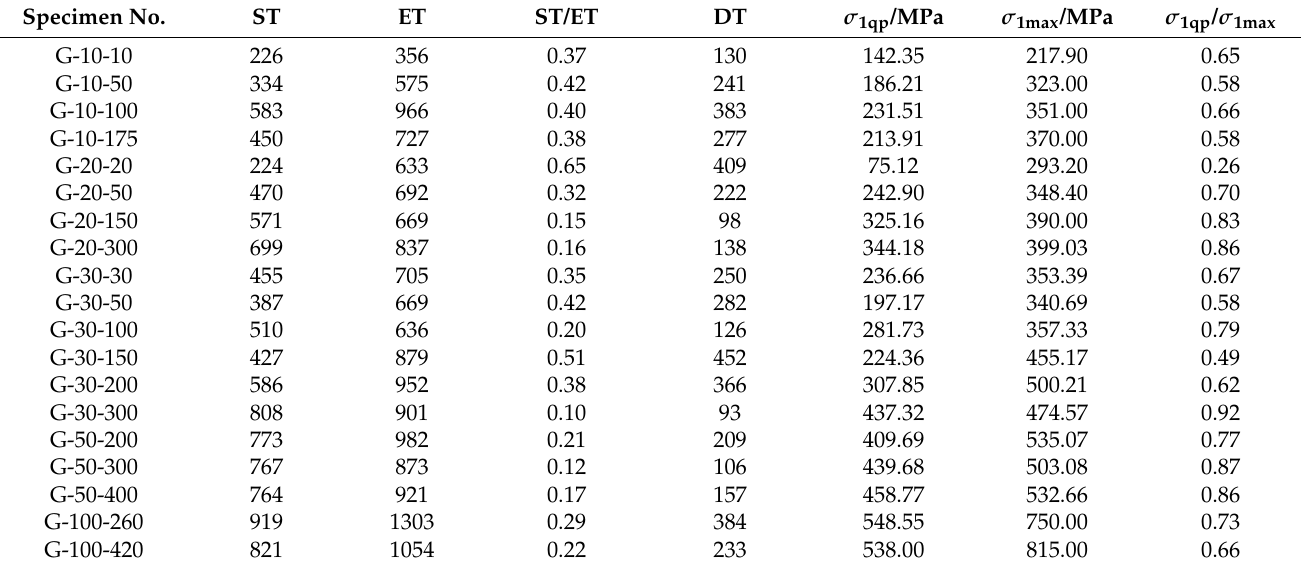
Table 1. Relationship between AE and σ 1 in the quiet period.